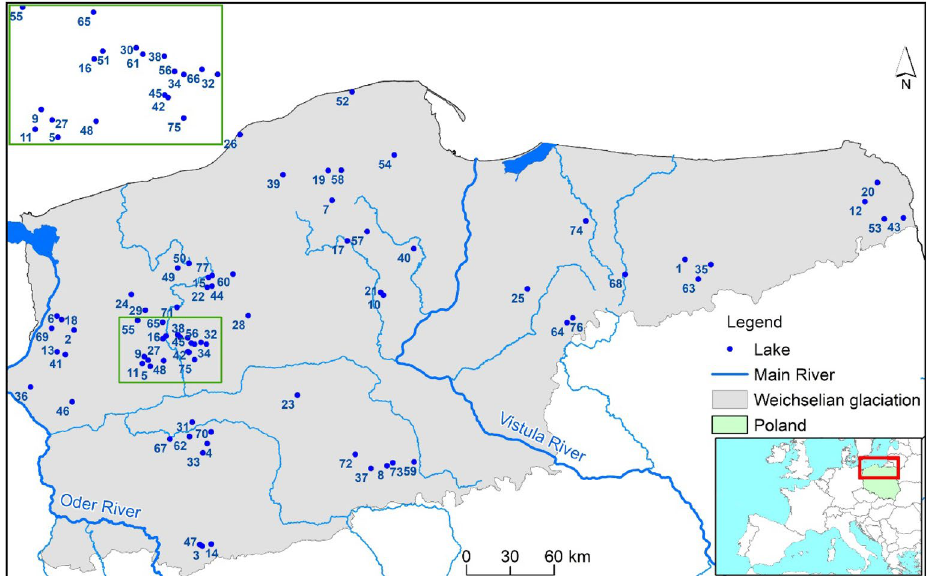
Figure 1. Study site location (the figure was generated in ArcMap 10.7, https:// deskt op. arcgis. com/ en/